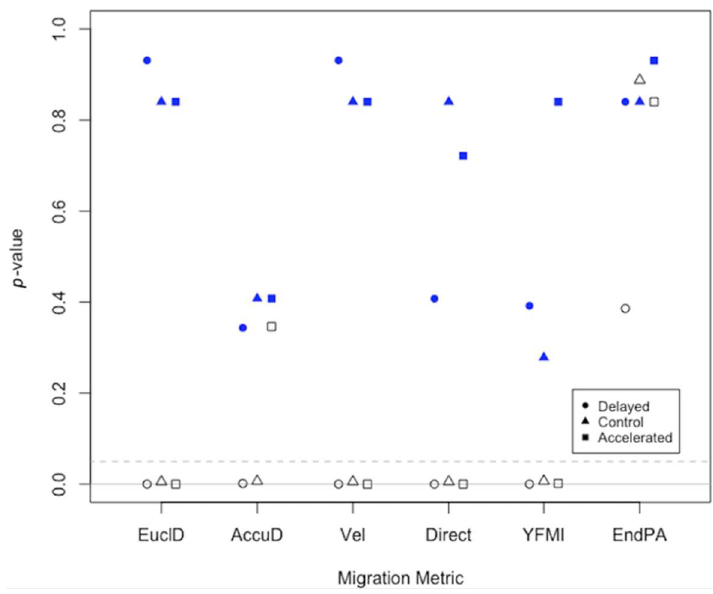
Figure 5. Comparison of the cell migration metrics produced by EPIC and Viterbi to manual cell tracking. Each symbol represents a p -value for pairwise comparisons of the sampled cell tracks from EPIC and manual cell tracking (blue filled) and Viterbi and manual cell tracking (black empty) for the delayed, control and accelerated experiments. We performed pairwise comparisons using two-sample Wilcoxon–Mann–Whitney tests. The statistical significance level was set to p < 0.05 (indicated by the dashed grey line). The solid grey line indicates y = 0. Metrics are shown in the following order and are abbreviated for clarity in the figure: Euclidean distance, accumulated distance, velocity, directionality, Y-forward migration index and end point